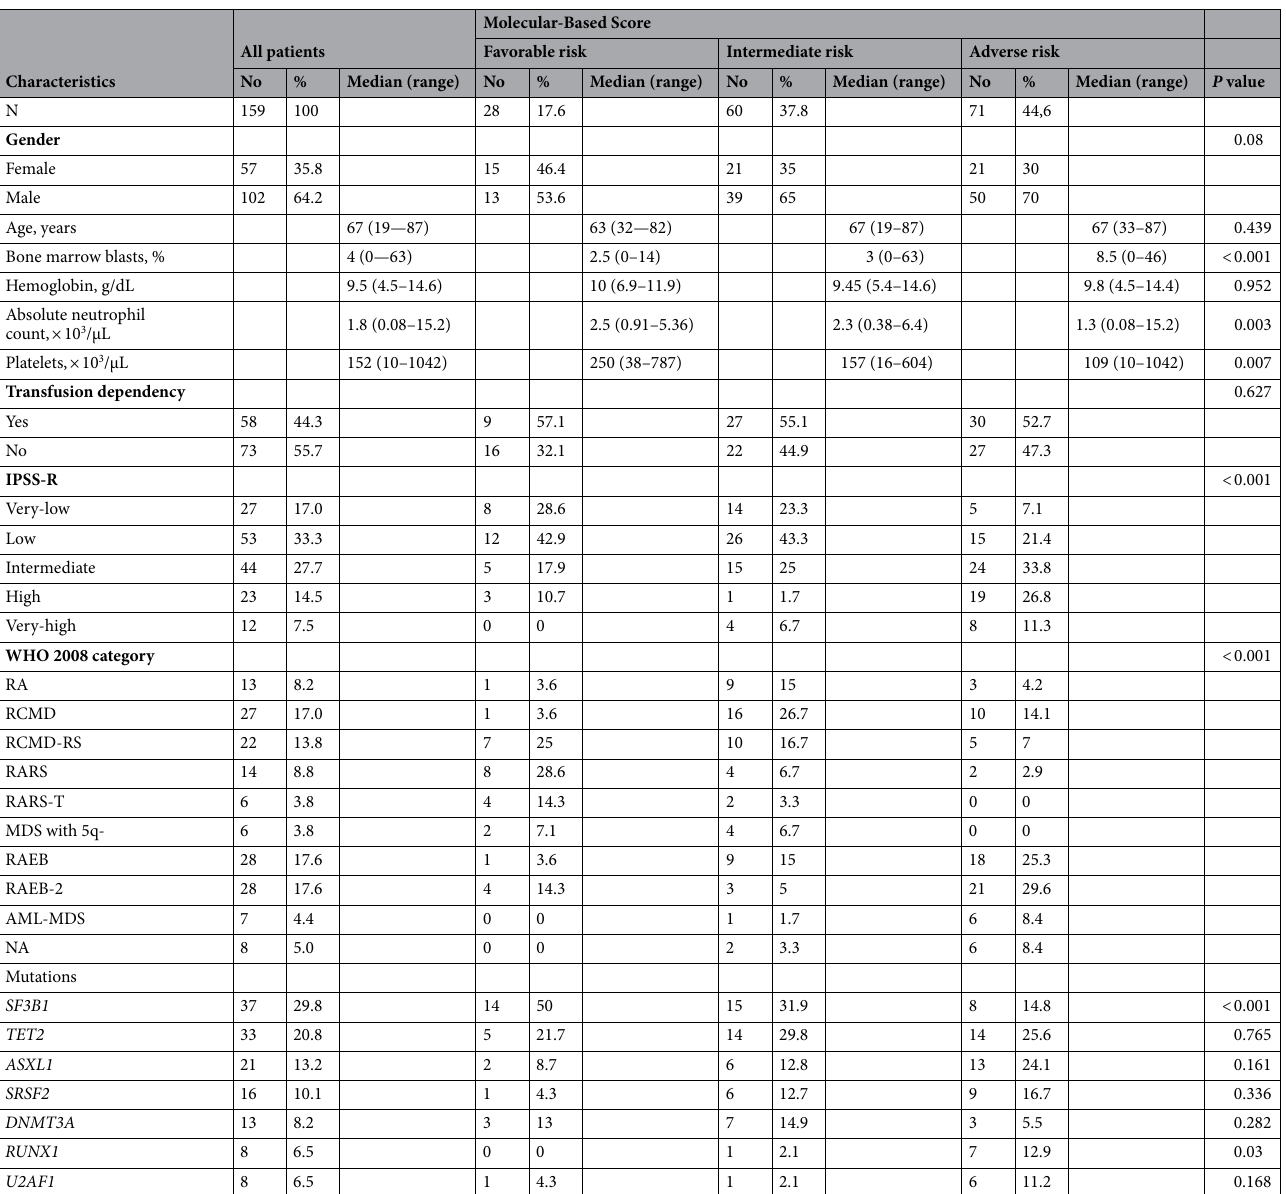
Table 3. Baseline characteristics of patients included for Molecular-Based Score. IPSS-R: Revised International Prognostic Score System ; RA: refractory anemia; RCMD: refractory cytopenia with multilineage dysplasia; RCMD-RS: refractory cytopenia with multilineage dysplasia with ring sideroblasts; RARS: refractory anemia with ring sideroblasts; RARS-T: refractory anemia with ring sideroblasts and thrombocytosis;